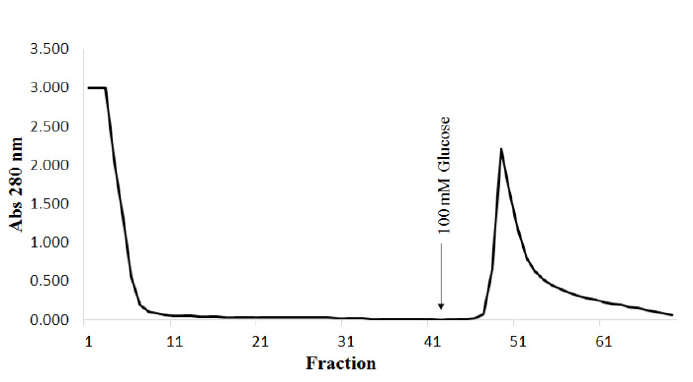
Figure 1. Elution profile of the Sephadex ® G-50 affinity chromatography. Approximately 10 mL of the crude extract was applied to the column (6.5 × 1.8 cm) which was equilibrated with 150 mM NaCl plus 5 mM CaCl and 5 mM MnCl . The lectin was eluted 2 2 with 100 mM D-glucose in the equilibrium solution described earlier at a flow rate of 1 mL/min. Fractions of approximately 3 mL were collected and monitored for protein content by measuring the absorbance at 280